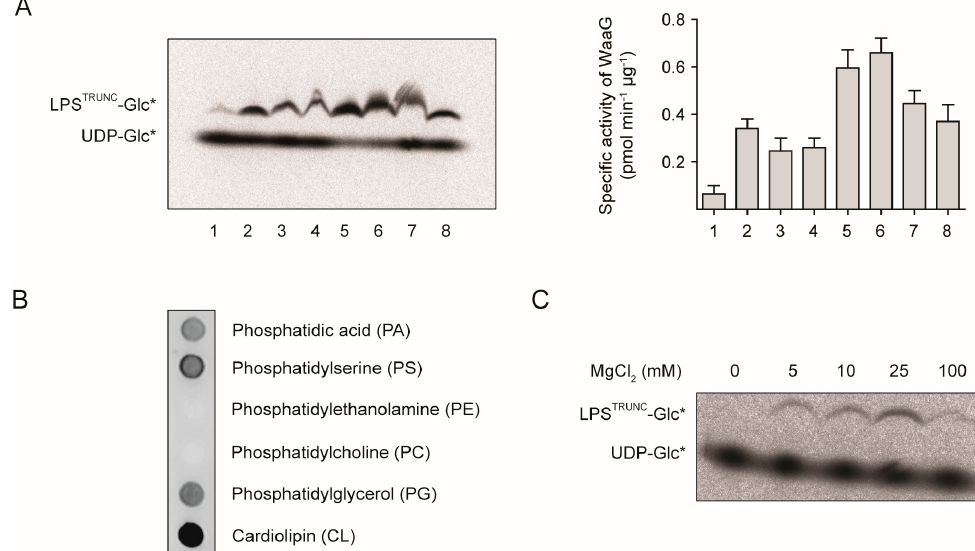
Figure 2. His-WaaG activity under different lipid compositions. ( A ) Mixed micelles containing CHAPS and/or various lipids were incubated with LPS TRUNC (0.5 µg·mL − 1 ), UDP-Glc* and His-WaaG (0.1 mg·mL − 1 ) to monitor LPS-glycosylation. After 1 h, the reaction was stopped by the addition of Laemmli buffer, and the products were separated by SDS-PAGE and detected by digital autoradiography. Lane 1: no added lipids or detergents; Lane 2: 20 mM CHAPS; Lane 3: 10 mM PG; Lane 4: 5 mM CL; Lane 5: 20 mM CHAPS + 10 mM PG; Lane 6: 20 mM CHAPS + 10 mM PG + 1 mM CL; Lane 7: 20 mM CHAPS + 10 mM PG + 5 mM CL; Lane 8: 3% DHPC. Quantification of LPS TRUNC -Glc* and UDP-Glc* was performed with ImageJ and the specific activity calculated (see the Experimental Section). Specific activities plotted as the mean ± SD; n = 2. ( B ) Nitrocellulose membranes containing immobilized lipids (100 pmol/spot) were incubated with purified His-WaaG (3 µg·mL − 1 ). After washing to remove unbound protein, His-WaaG that bound to different lipids was detected by immunoblotting with antisera to the His-tag. ( C ) His-WaaG activity was monitored in vitro with different concentrations of MgCl 2 .